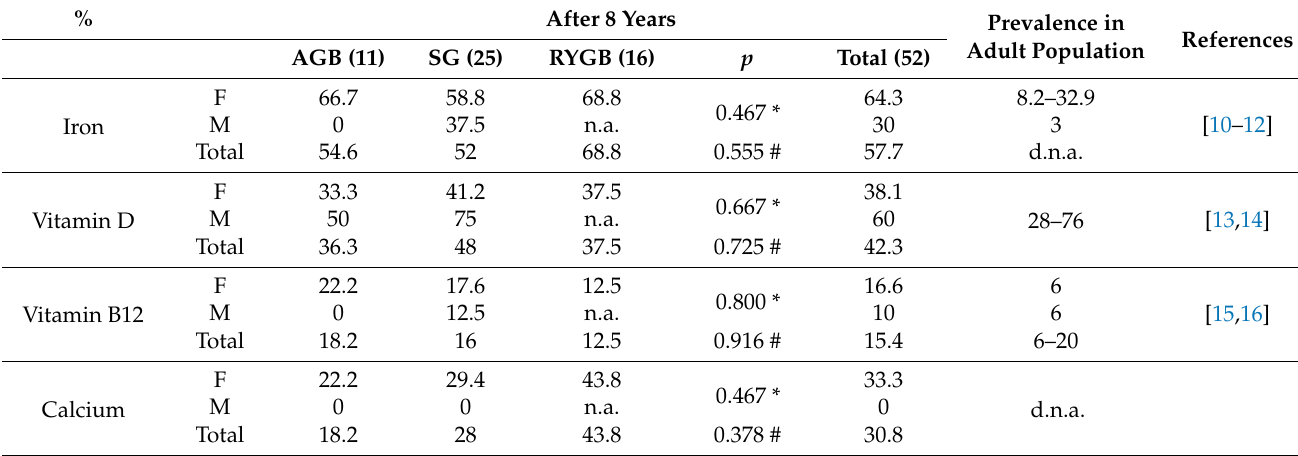
Table 3. Patients’ nutritional deficiencies (%).